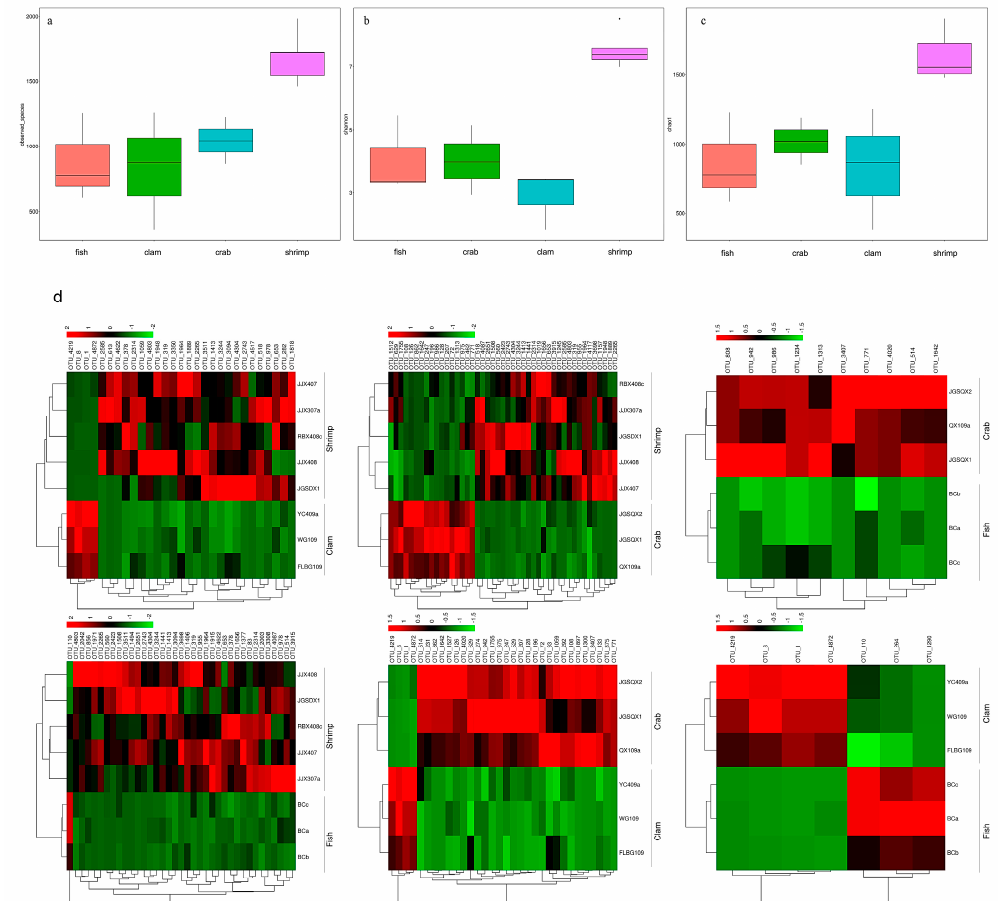
Figure 1. Species ( a ), Shannon ( b ), and Chao1 indices ( c ) of bacterial intestinal communities in different aquatic animal groups. Significant differences were observed in operational taxonomic units (OTUs) in different aquatic animal intestines ( d ).